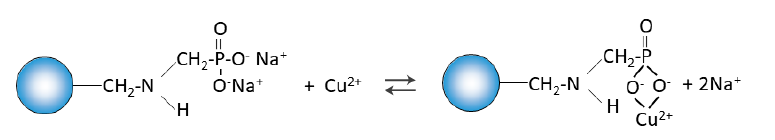
Figure 16. Proposed sorption mechanism.